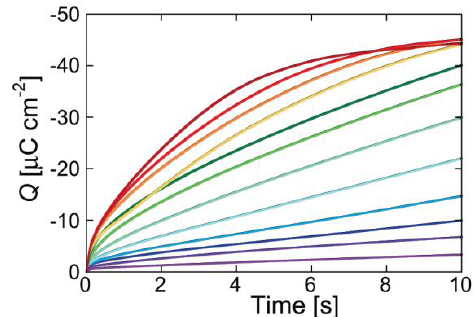
Figure 6. Charge vs. time curves following potential steps from a fixed initial potential of −0.200 V to progressively more negative final potentials, E f , varying from −0.525 to −0.925 V by −25 mV increments, at a DPTL/DPhPC tBLM incorporating gramicidin from its 0.1 μM solution in aqueous 0.1 M KCl. (Reprinted with permission from [16]. Copyright 2007, American Chemical